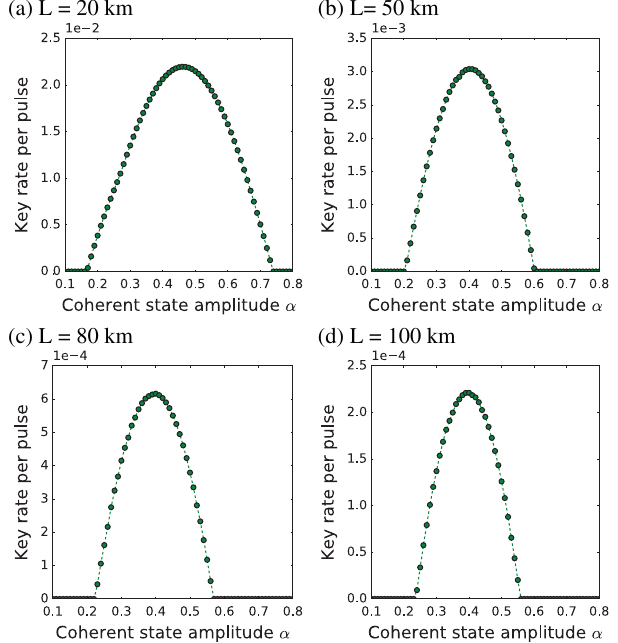
FIG. 3. Secure key rate for protocol 1 versus coherent state amplitude α for selected choices of distances (a) L ¼ 20 km, (b) L ¼ 50 km, (c) L ¼ 80 km, and (d) L ¼ 100 km with the excess noise ξ ¼ 0 . 01 and reconciliation efficiency β ¼ 0 . 95